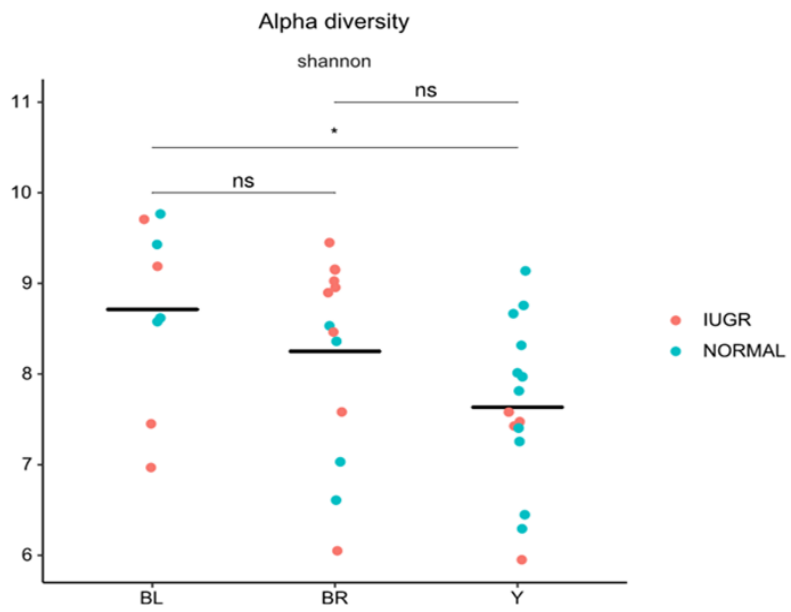
Figure 4. Alpha diversity identified in yellow, brown, and black colon content of normal and intrauterine growth-restricted (IUGR) piglets at weaning.